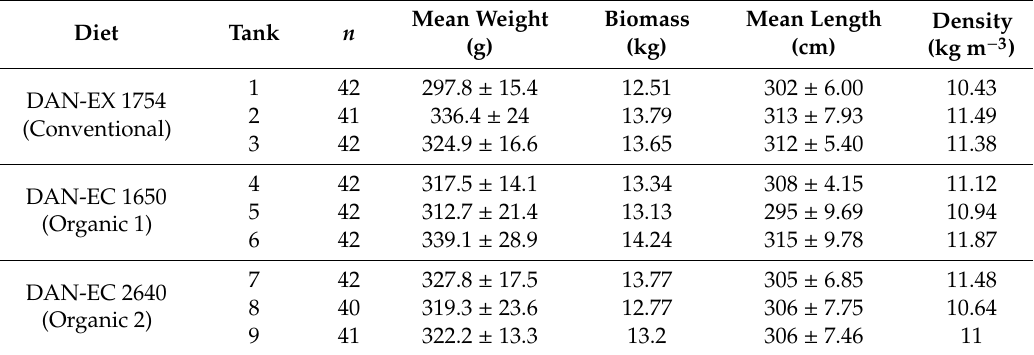
Table 1. Mean ± SEM of the morphometric and rearing variables for the three tanks of each diet at the beginning of the experiment. Fish mean weights and mean total lengths were not statistically di ff erent in the nine experimental tanks (Kruskal-Wallis, p >